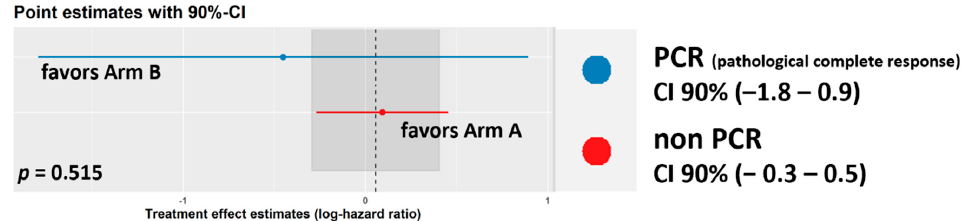
Figure 2. Plot of unadjusted treatment effects for pCR and non-pCR subgroups for disease-free survival. The 90% confidence interval is plotted. The overall treatment effect under the model with no treatment-subgroup interactions are plotted with a dashed line, as well as its confidence intervals plotted as a gray shaded area. Statistical significance was examined and plotted with the “subtee” package in R.